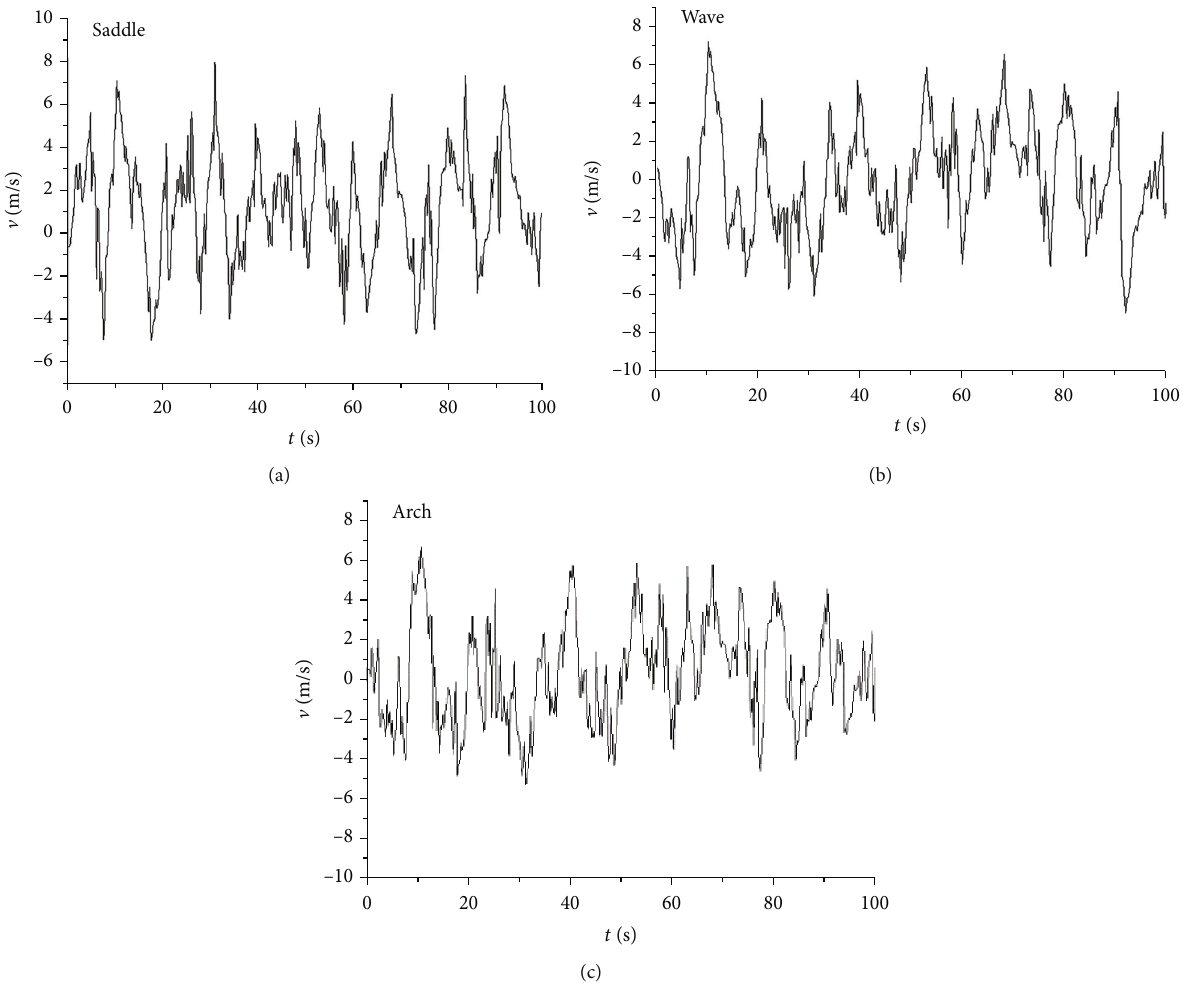
Figure 4: (a) Wind speed time series of the saddle roof. (b) Wind speed time series of the wave-shaped roof. (c) Wind speed time series of the continuous arch roof. v is the fl uctuating wind speed; t is the time series. The fl uctuating wind acts on the roof surface